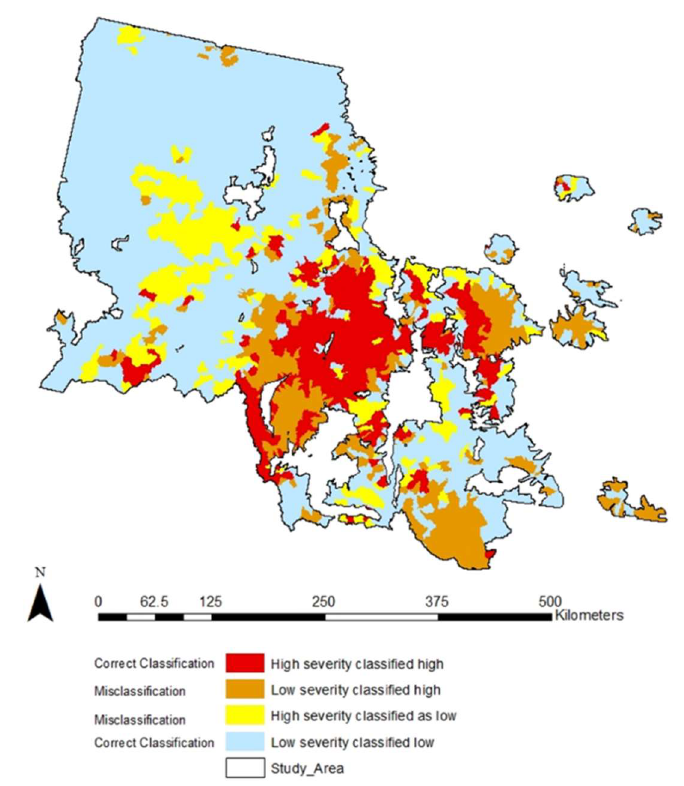
Figure 6. Results of the simplest model for the study area, indicating where subwatershed MPB attack severity was correctly classified and misclassified.